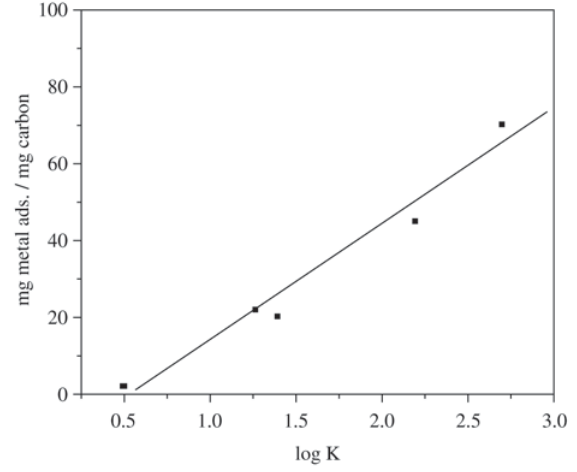
Figure 8. Stability constants versus adsorption capacity for the different metal cations onto 16 h reflux treated carbon.